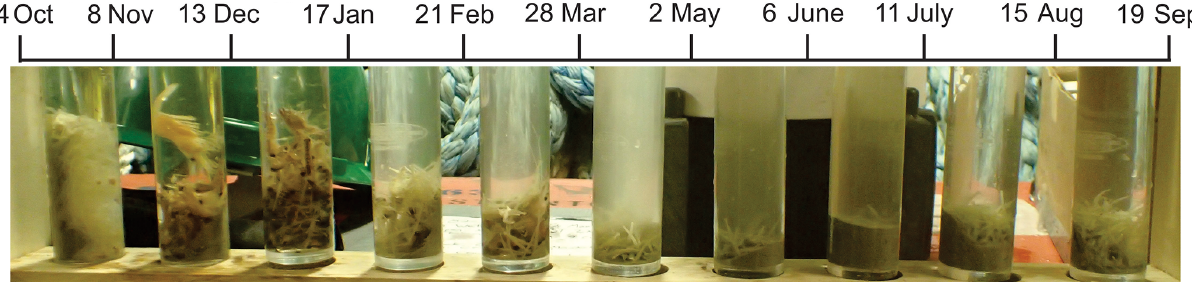
Figure 6. Contents of the sediment trap for 10 intervals of